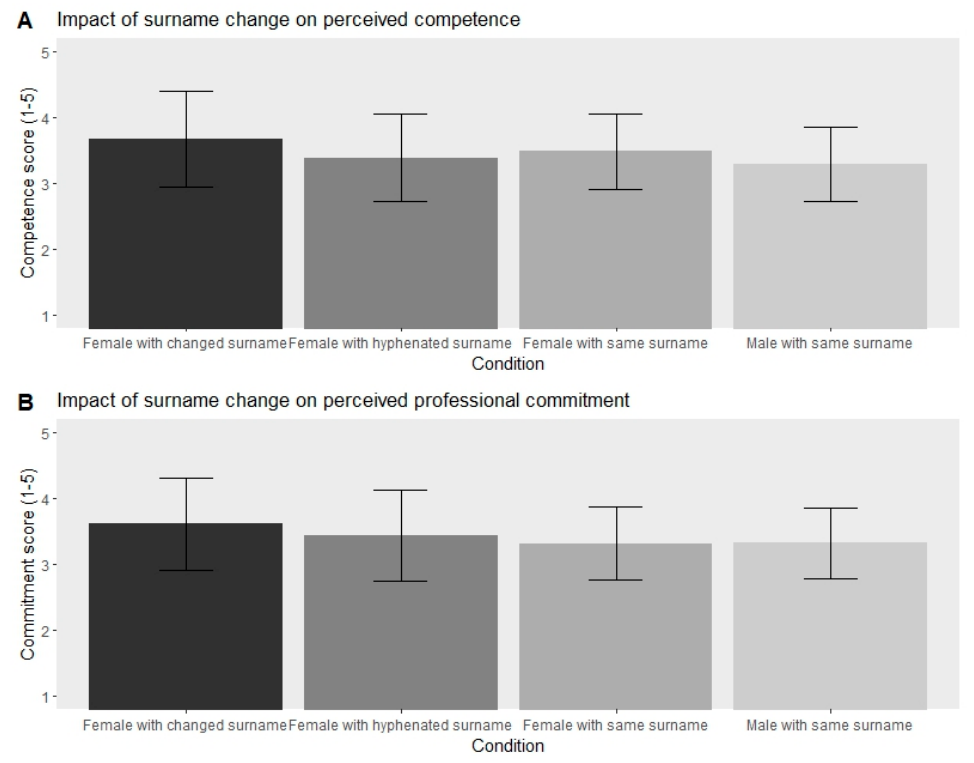
Figure 2. Female job candidates who changed their surname received higher competence (panel A ) and commitment scores (panel B ) compared to other groups.